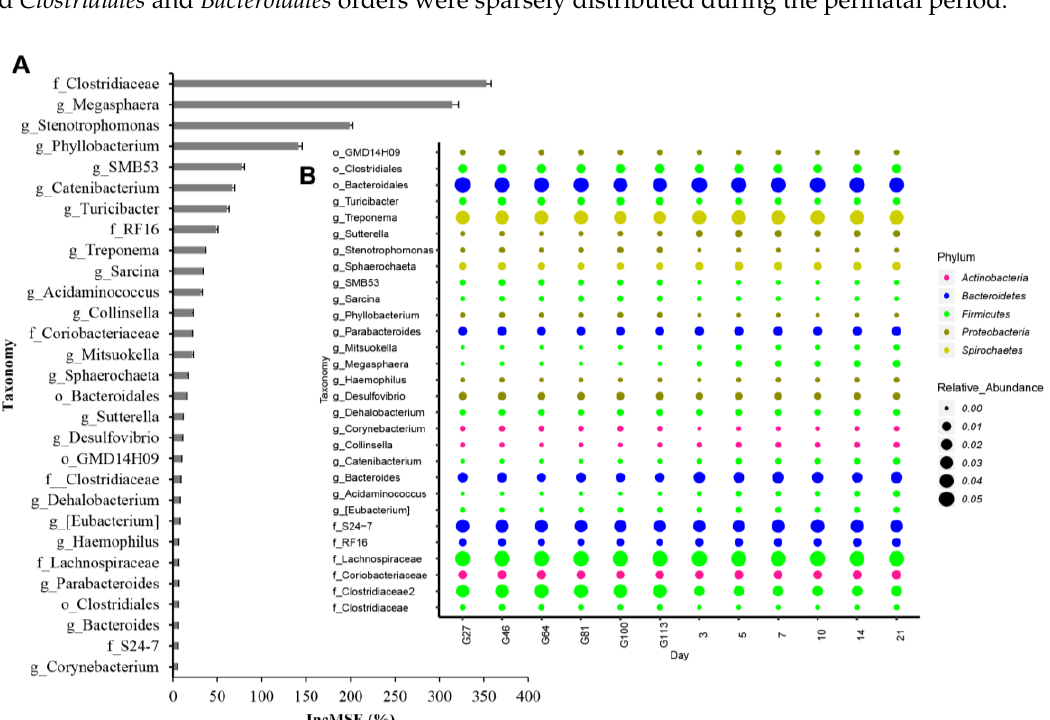
Figure 4. Perinatal bacterial function prediction. ( A ) The functional differences of bacteria at different time points during the prenatal period; ( B ) the functional differences of bacteria at different time points during the postnatal period.